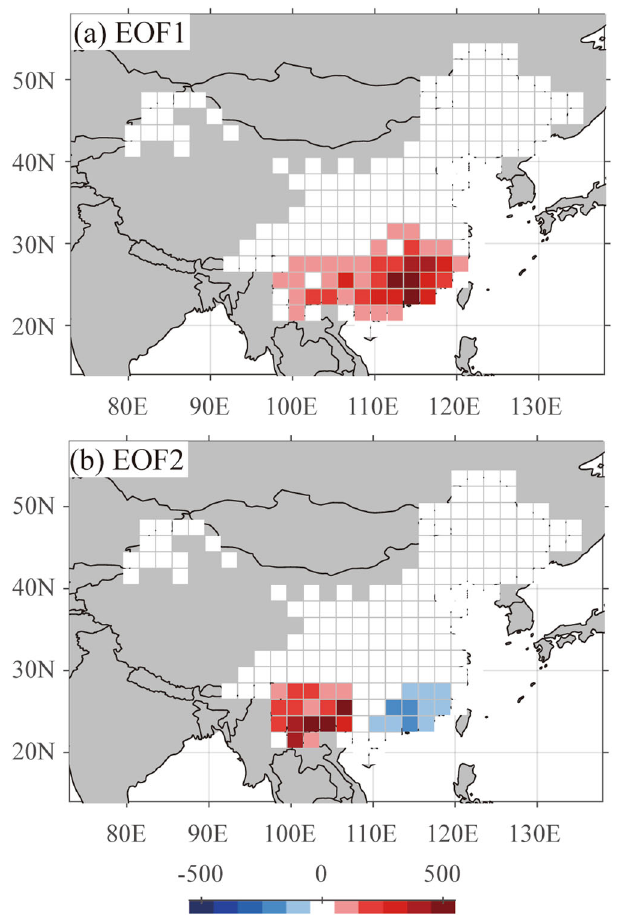
Fig.2|Spatialpatternsofthe fi reoccurrencesinChina. The a fi rstand b second empirical orthogonal basis functions (EOF1 and EOF2) represent the spatial dis- tribution of wild fi re occurrence from the Wild fi re Atlas of China (WFAC). These basis functions account for 54 and 19% of total